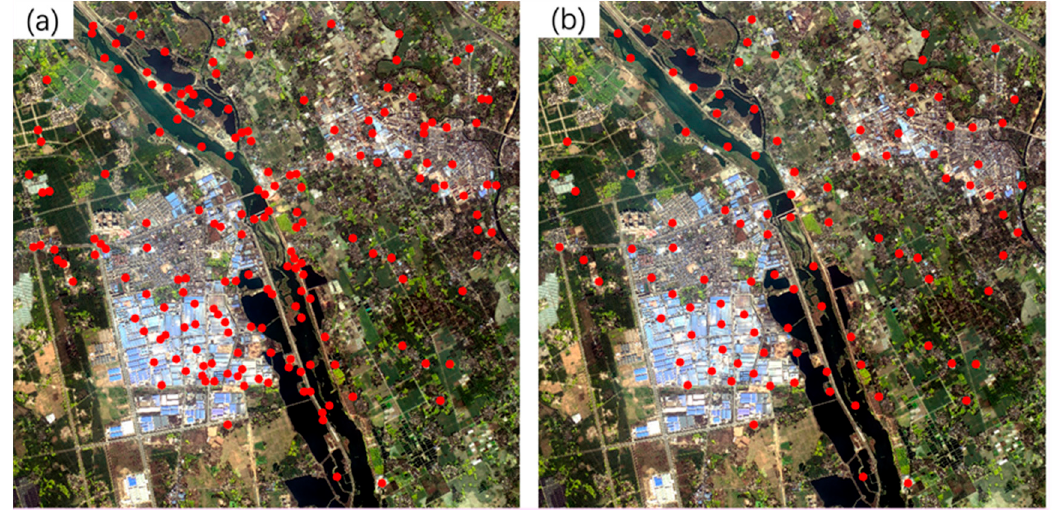
Figure 7. Comparison of the spatial distribution of the initial matched tie points ( a ) and the remaining tie points after removing some tie points with high density ( b ).